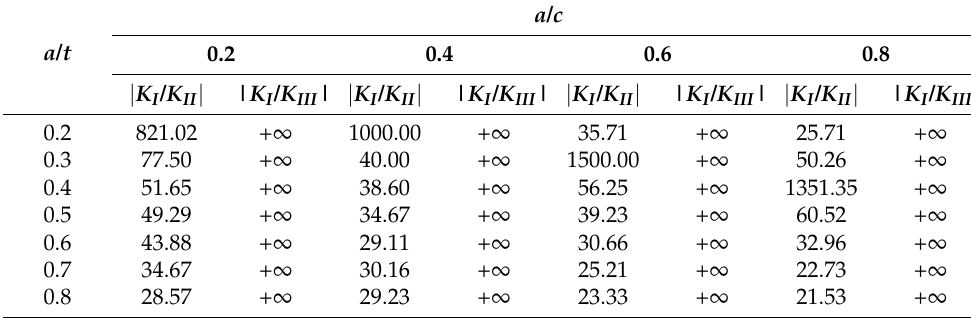
Table 2. The ratios of | K I / K II | and | K I / K III | at the deepest point of the crack.